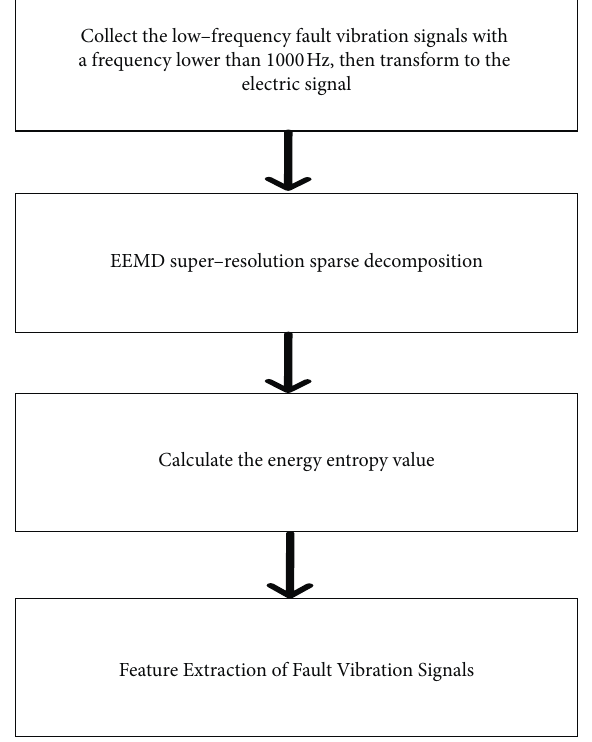
Figure 2: The specific processing steps